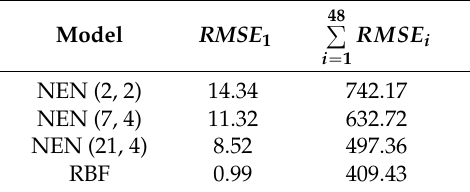
Table 2. RMSEs of Relative Humidity.